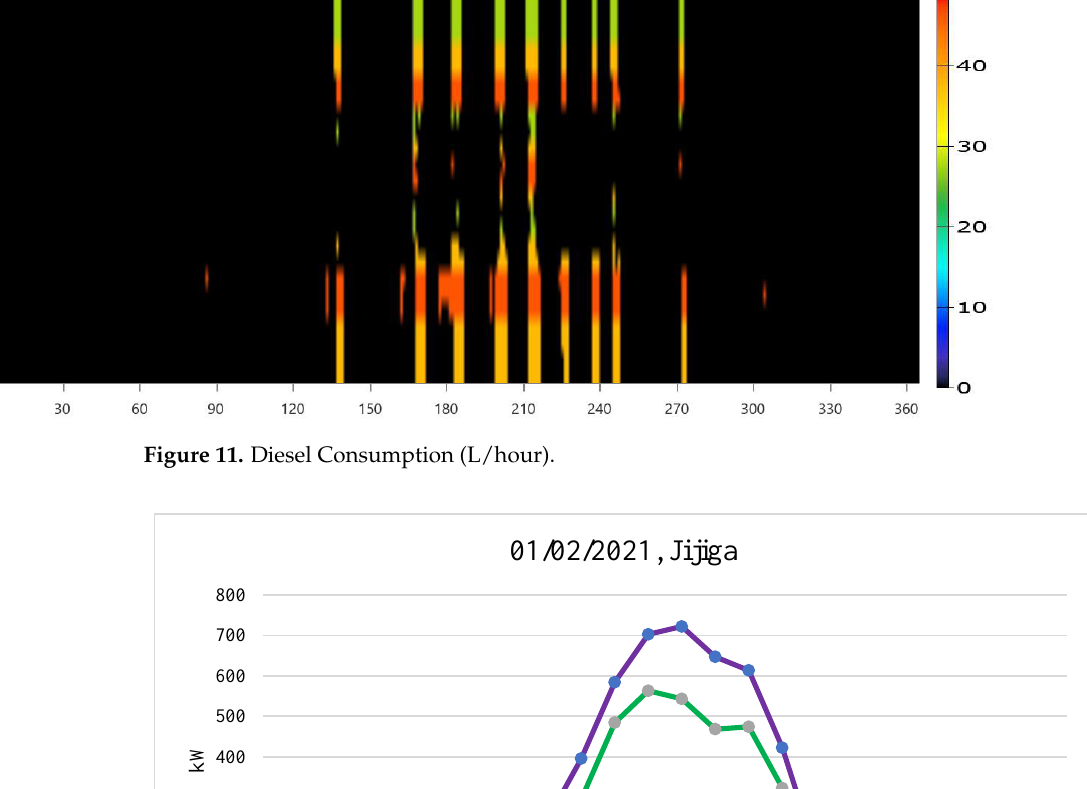
Figure 10. Monthly Average Electric Production.